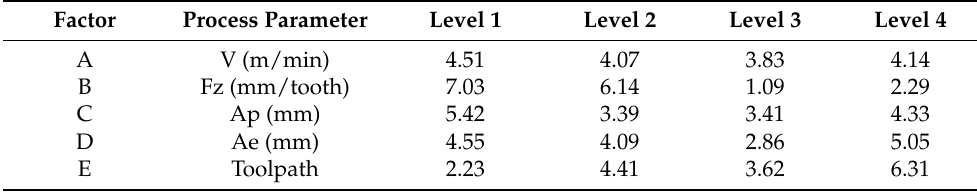
Table 5. SN ratio values for deformation.